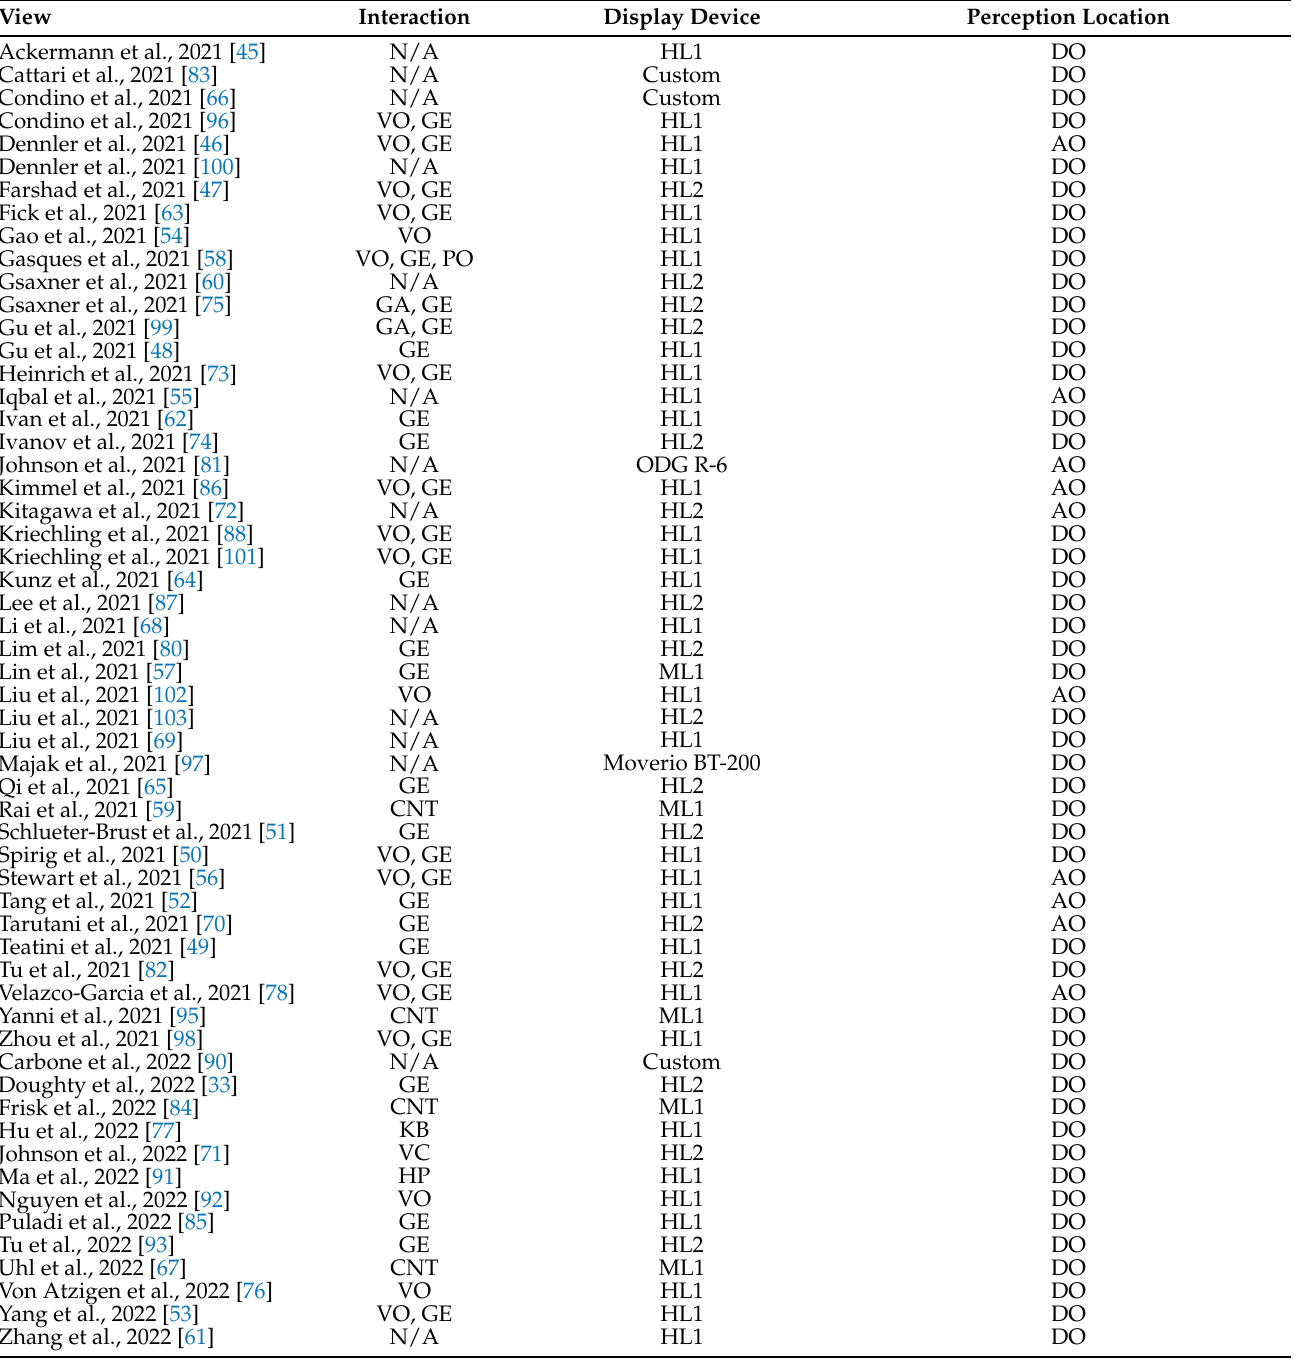
Table 5. Papers categorized by the view type used. Interaction types included voice (VO), gesture (GE), gaze (GA), keyboard (KB), head pose (HP), pointer (PO), and controller (CNT). Display devices included the HoloLens 1 (HL1), HoloLens 2 (HL2), and Magic Leap One (ML1). Perception